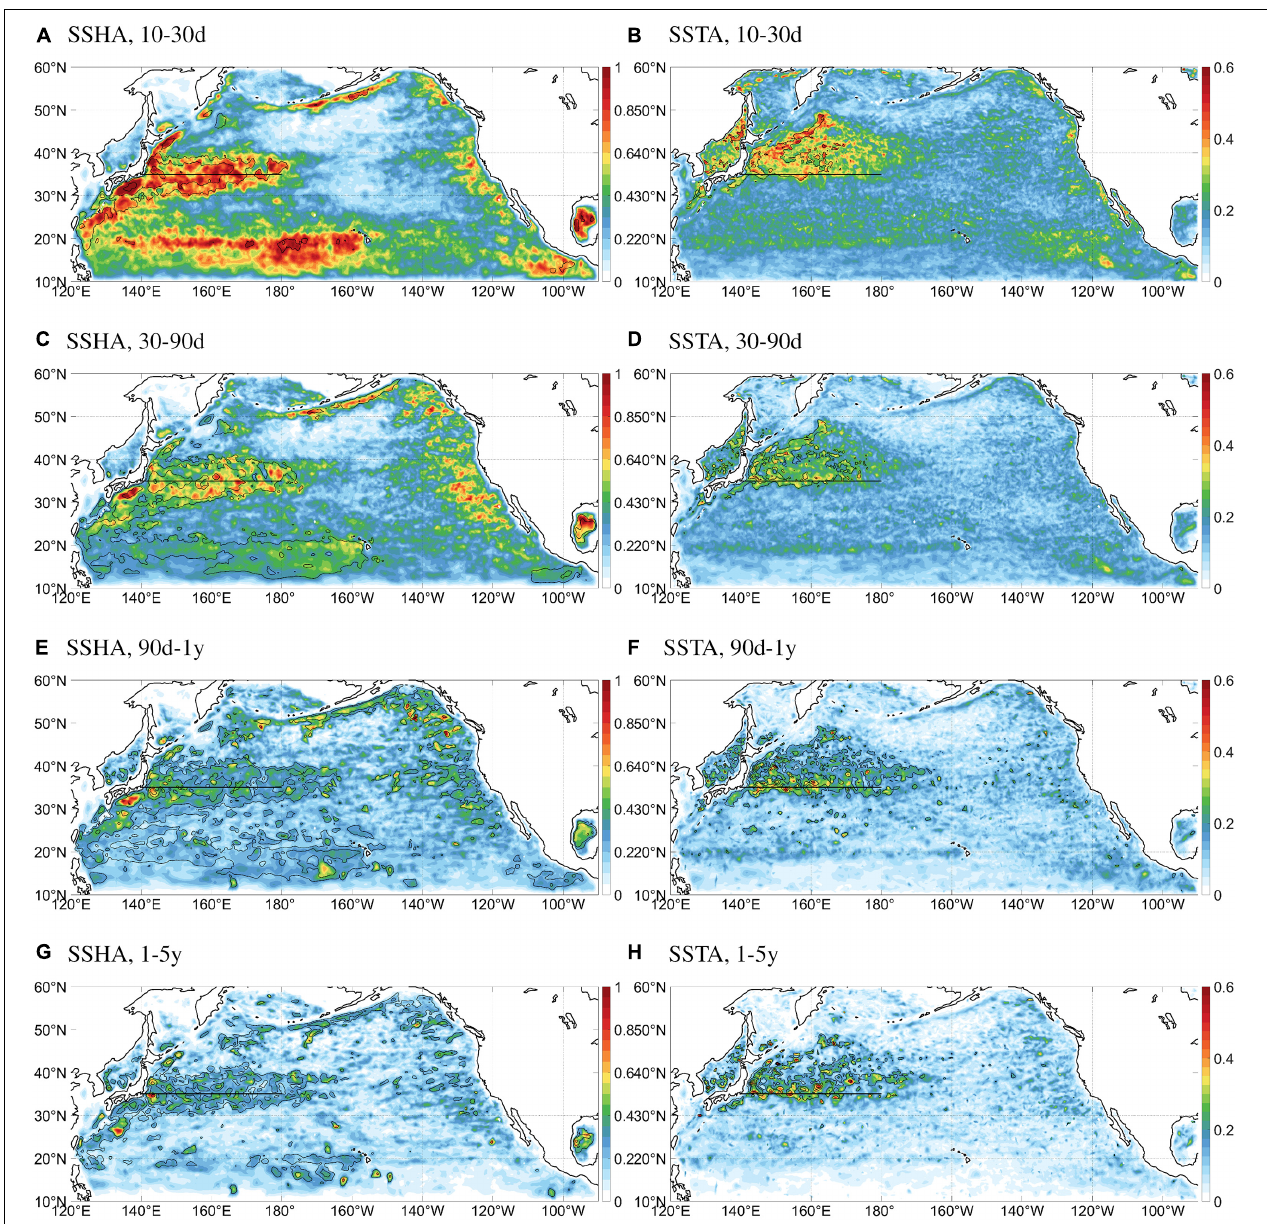
FIGURE 10 | Ratio of standard deviation of eddy-induced and original variability for (A,C,E,G) SSHA, and (B,D,F,H) SSTA on (A,B) sub-monthly (10–30 days), (C,D) intraseasonal (30–90 days), (E,F) intra-annual (90 days–1 year), and (G,H) inter-annual (1–5 years) timescales. The black line indicates the climatological position of the KE jet at 35 ◦ N. Note the different color scale for SSTA. Contours show the standard deviation of the eddy-induced